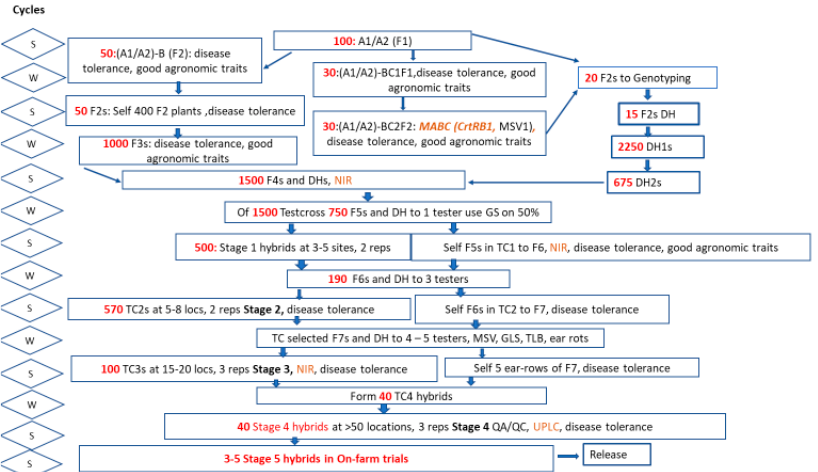
Figure 1. PVA breeding scheme used at CIMMYT. In red, number of lines or crosses used at each stage. In orange, stages where PVA traits are screened either genotypically (bold and italics) or phe- notypically. Abbreviations: S: Summer cycle; W: Winter cycle; MABC: Marker assistant backcrosses; DH: double haploids; CrtRB1: β -carotene hydroxylase 1; MSV: Mosaic streak virus; GS: Genomic selection; TC: test cross; GLS: Gray leaf spot; TLB: Turcicum leaf bright; QA/QC: quality assur- ance/quality control; UPLC: Ultra performance liquid chromatography.